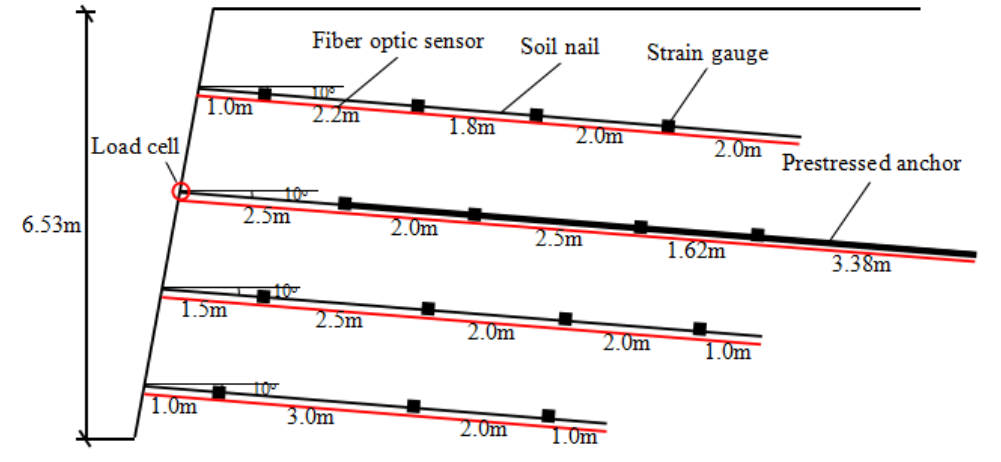
Figure 8. Location of instruments for No. 5.